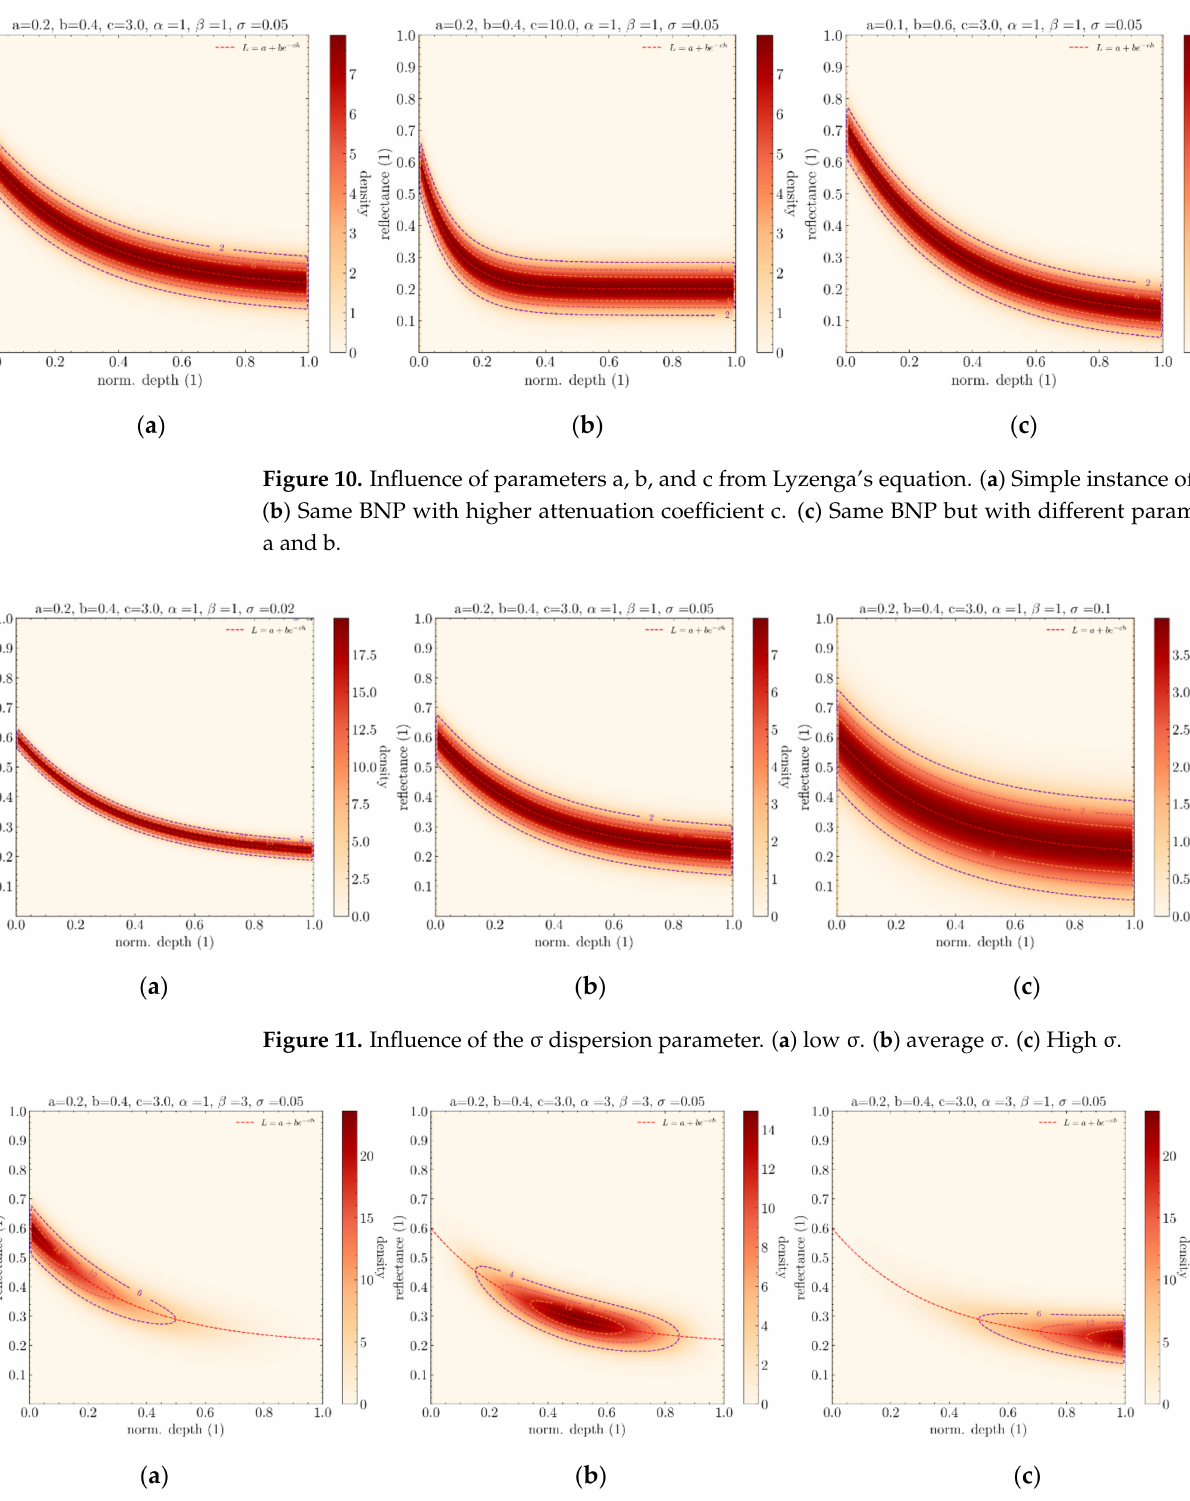
Figure 12. Influence of α and β parameters. ( a ) α < β . ( b ) α = β . ( c ) α > β